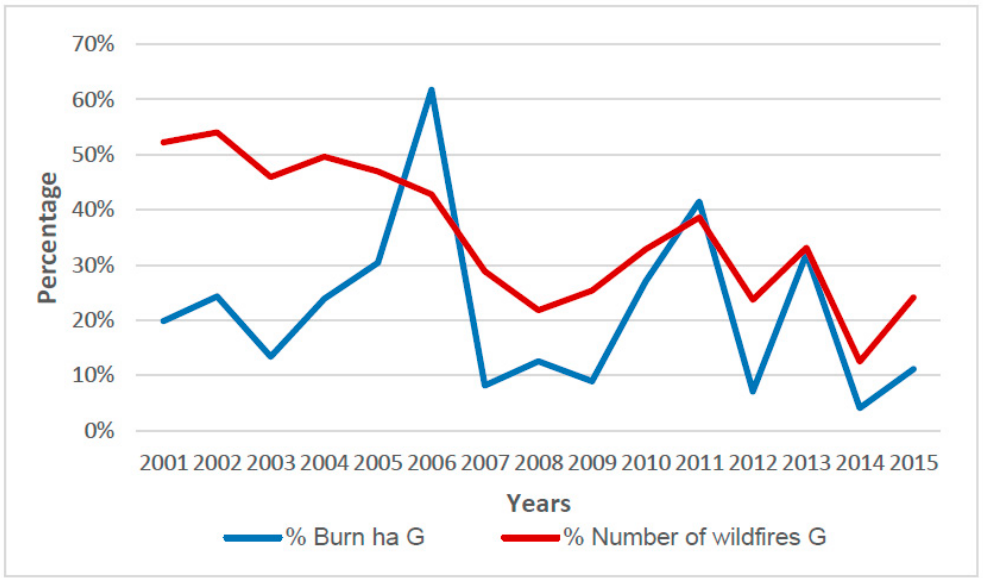
Figure 3. Burn ha and number of wildfires in Galicia in relation to Spain. 2001–2015. Source: Own elaboration from Nature Data Bank.